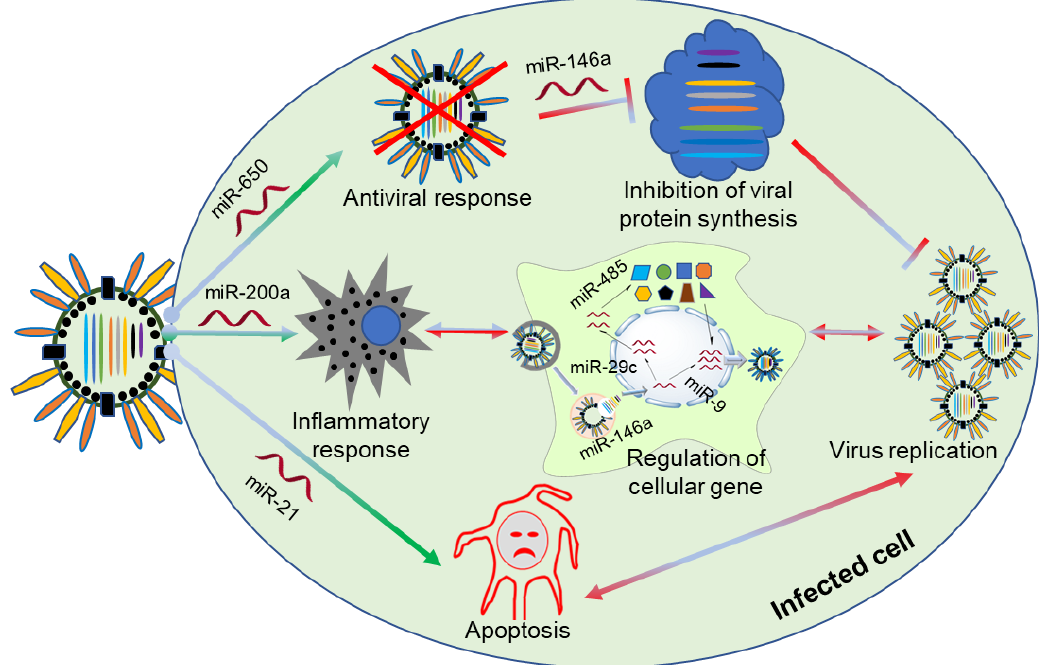
Figure 1. The involvement of miRNAs that modulate host-mediated pathways. IAV infection alters the expression profiles of certain cellular miRNAs related to viral replication, pathogenesis, and antiviral responses. Certain miRNAs have important roles in inflammatory responses and apoptotic pathways as well.